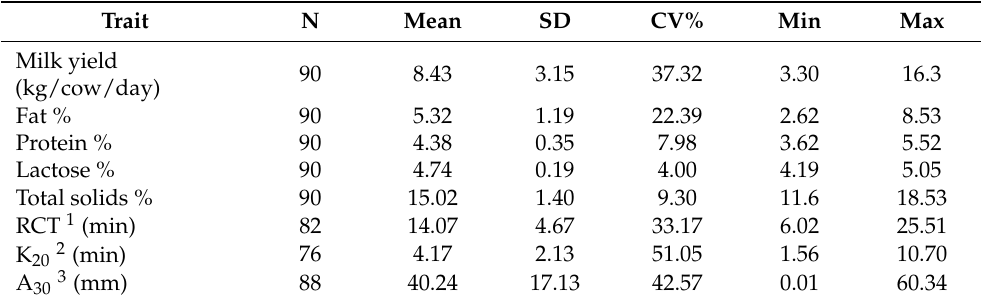
Table 2. Descriptive statistics of milk composition and milk coagulation properties of cows sampled during late lactation in the 2020–2021 production